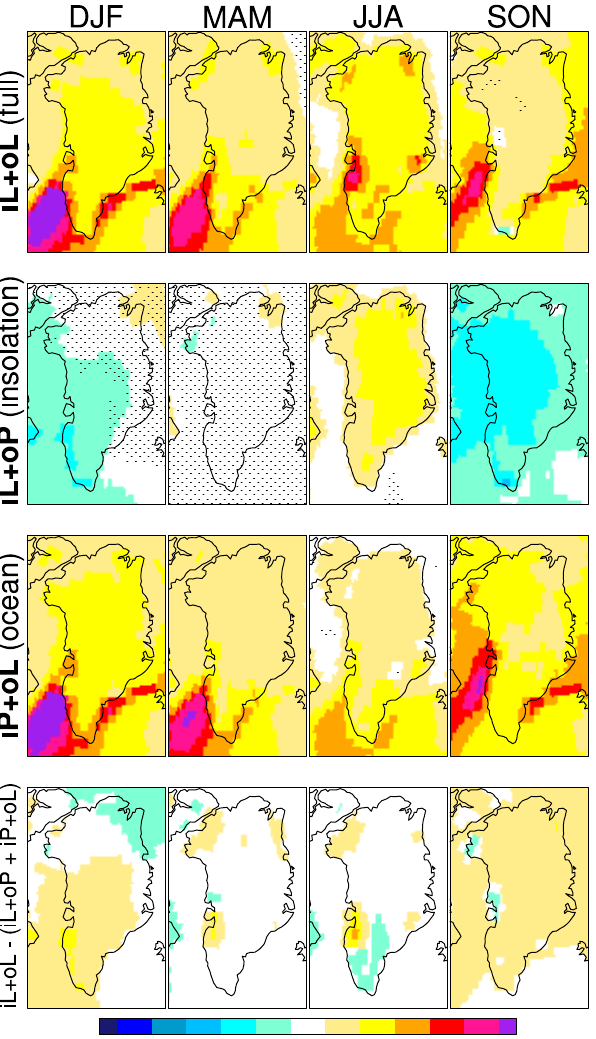
Figure 4. Seasonal mean relative snowfall anomalies (%) from iP+oP: iL+oL (top row), iL+oP (second row), iP+oL (third row), and the difference iL+oL − (iL+oP + iP+oL) (bottom row). Black dotted shading marks anomalies that are not statistically significant at the 95%